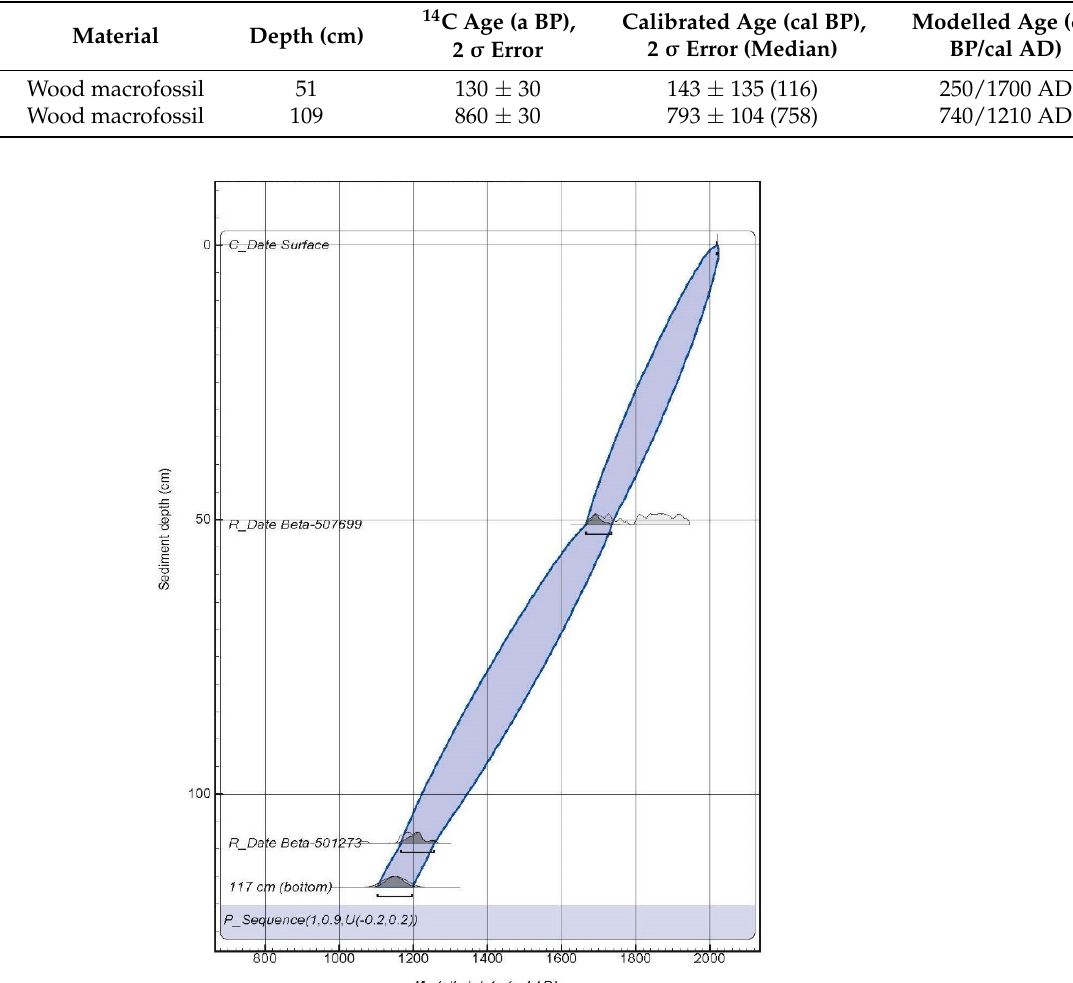
Table 1. AMS radiocarbon dates for samples extracted from the Spur Bog composite profile SPUR-A.